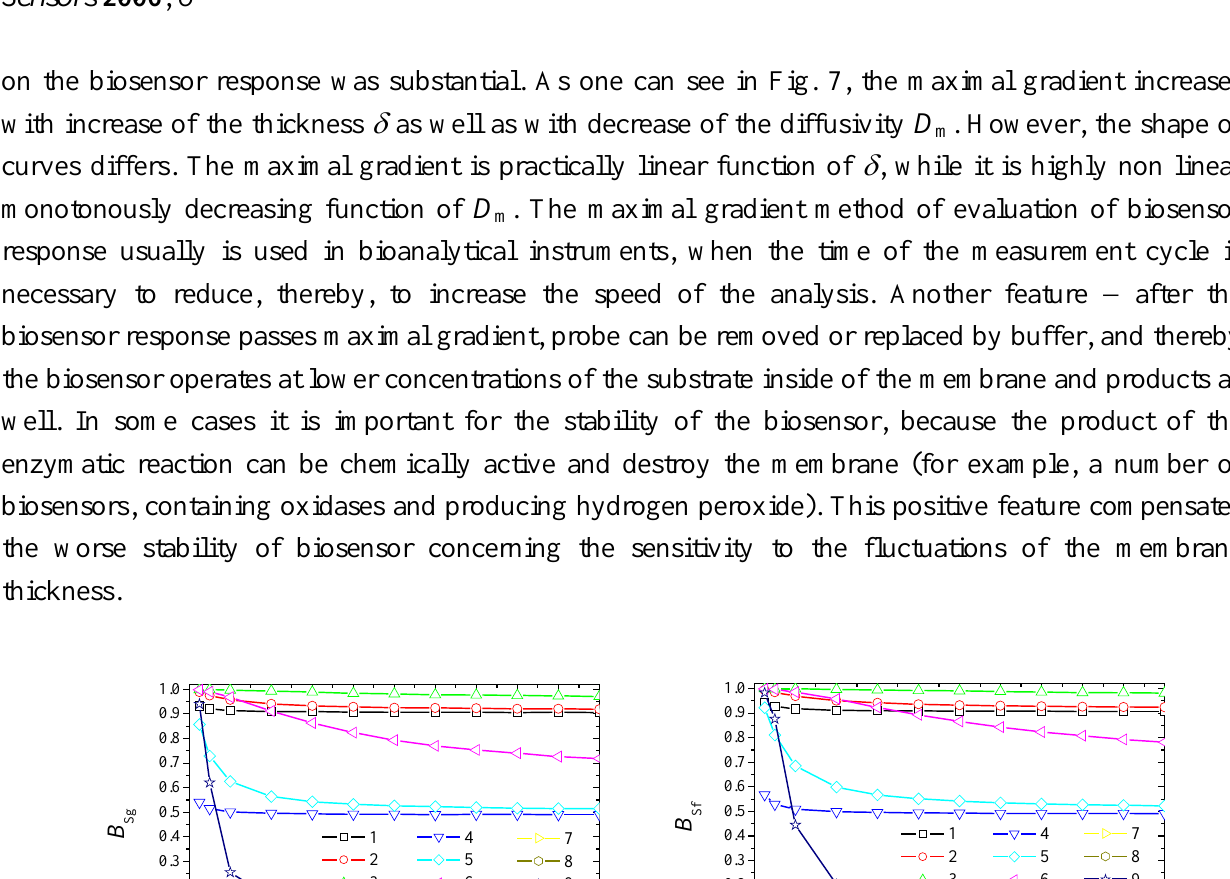
Figure 6 . The normalized biosensor sensitivity vs. the diffusivity D cases of plate − gap (a) and flat (b) biosensors, δ = 2 µ m, other parameters are the same as in Fig. 3.